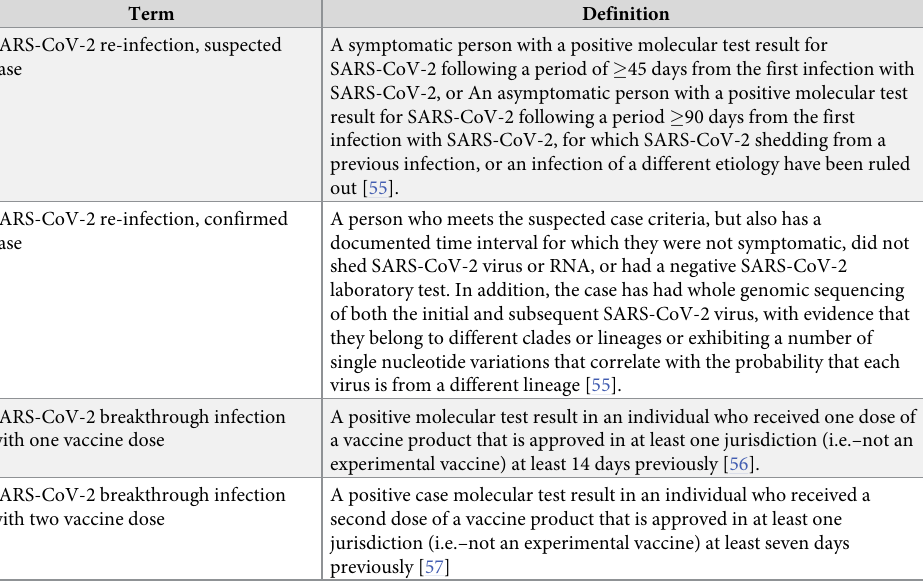
Table 1. Definitions applied to determine cases of re-infection and breakthrough in this systematic